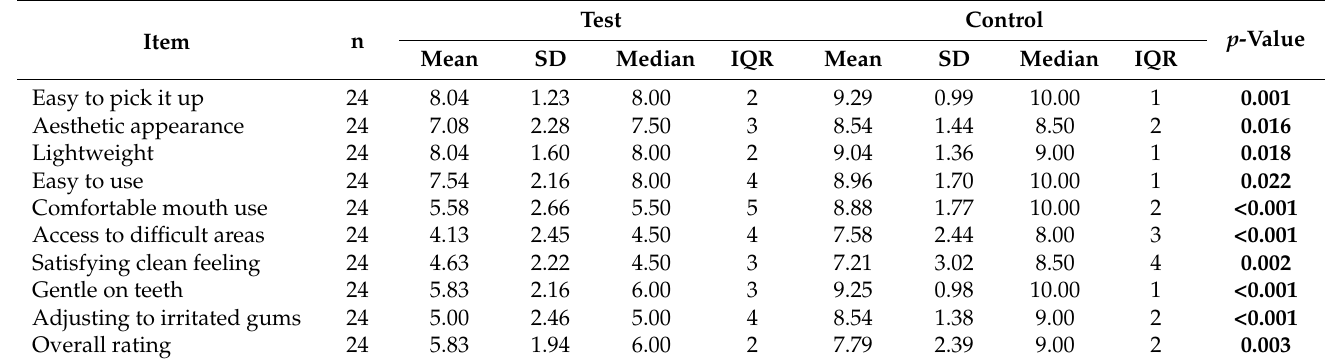
Table 6. Mean, standard deviations (SD), median and interquartile range (IQR) for the scores of the items assessed for each of the toothbrushes studied (patient-reported outcome measures). The answers were provided on a 1–10 scale.